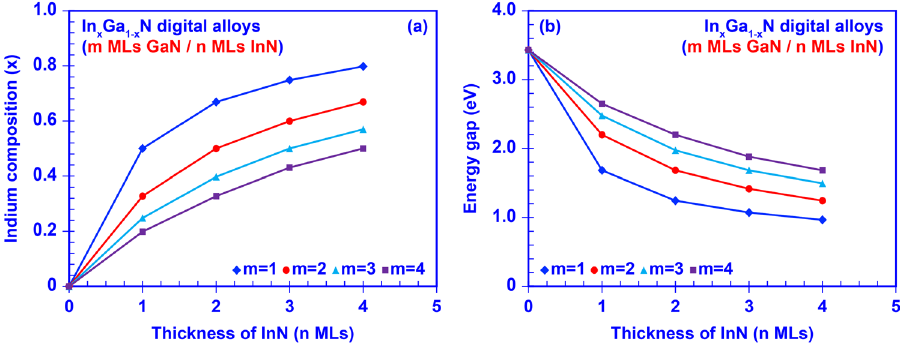
Figure 2. Empirical predictions of ( a ) tunability of In-Content in InGaN digital alloy and ( b ) tunability of energy gap in InGaN digital